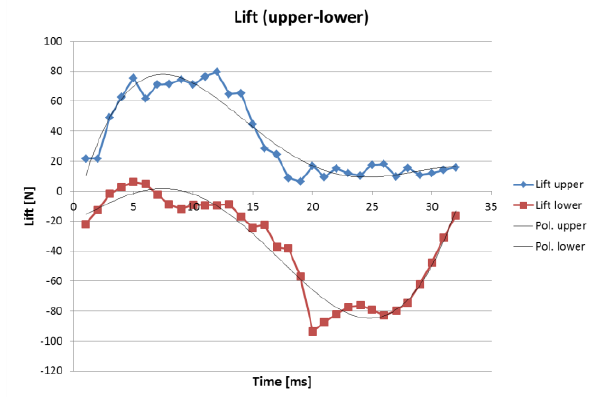
Fig. 8. Lift force in dependency on AoA, Ma = 0.45.